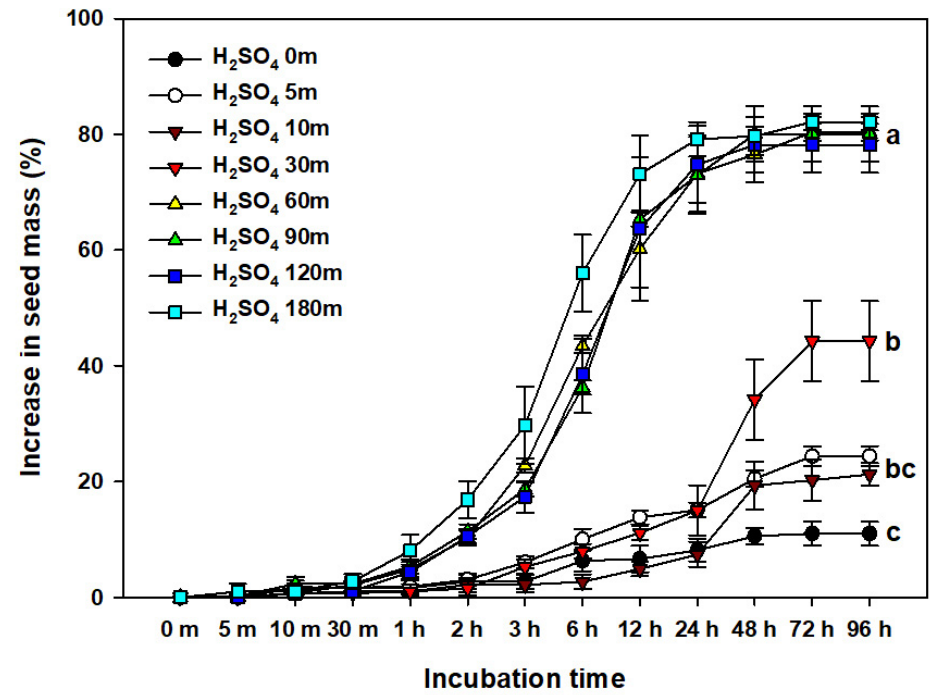
Figure 1. Effects of sulfuric acid scarification times on the increase in mass of Hovenia dulcis seeds. Seeds were scarified with 98% sulfuric acid at room temperature (20–25 °C). Vertical bars show ± SE of three replicates. The different letters represent statistically significant differences for germination percentages according to treatments in 96 h as determined by Duncan’s multiple range test ( p < 0.05).